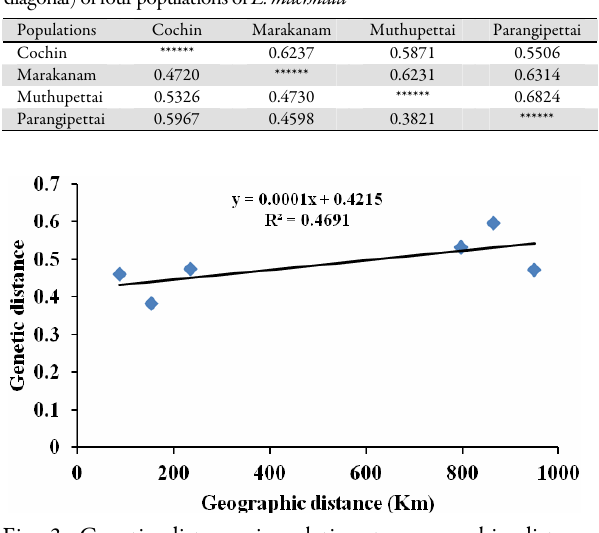
Fig. 3. Genetic distance in relation to geographic distance among the four